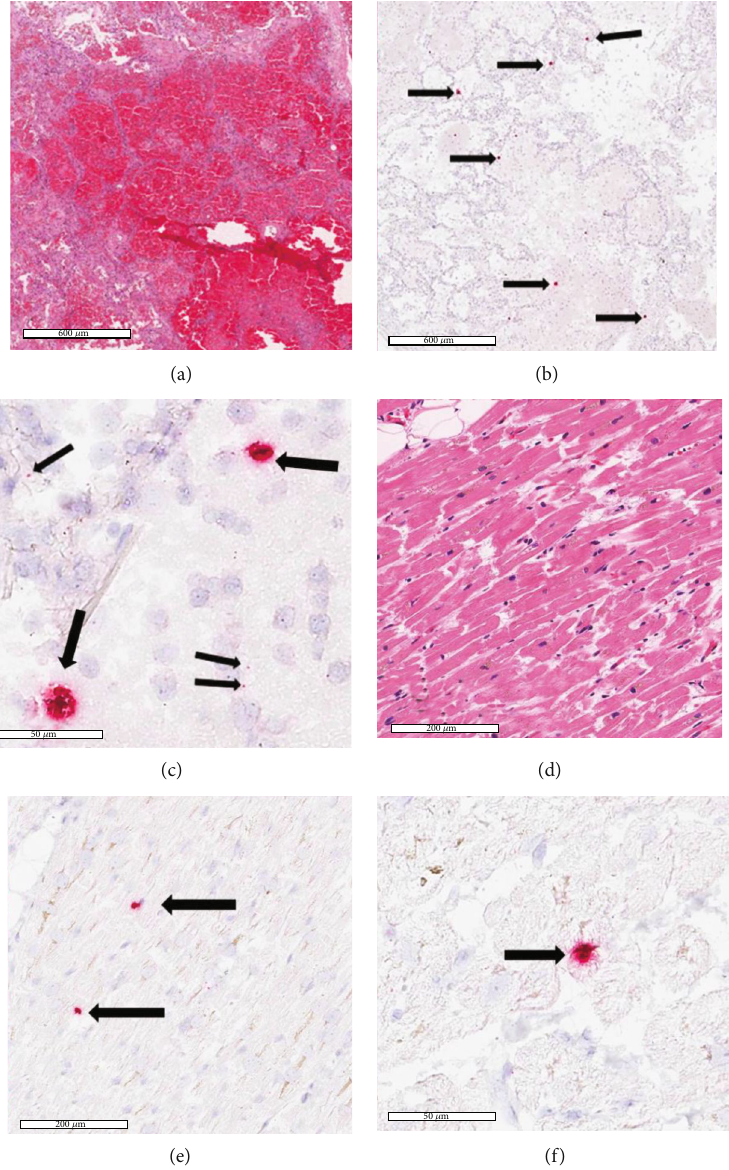
Figure 3: (a) Lung H&E 4x (scale bar: 600 μ m) with di ff use alveolar hemorrhage and alveolar fi brin. (b) SARS-CoV-2 ISH 4x (scale bar: 50 μ m). (c) SARS CoV-2 ISH 40x (scale bar: 50 μ m). (d) Heart H&E 20x E: Heart SARS-CoV-2 ISH 20x (scale bar: 200 μ m). (f) Heart SARS CoV-2 ISH 40x (scale bar: 50 μ m). Black arrows: positive antisense SA RS-CoV-2 RNA probe red